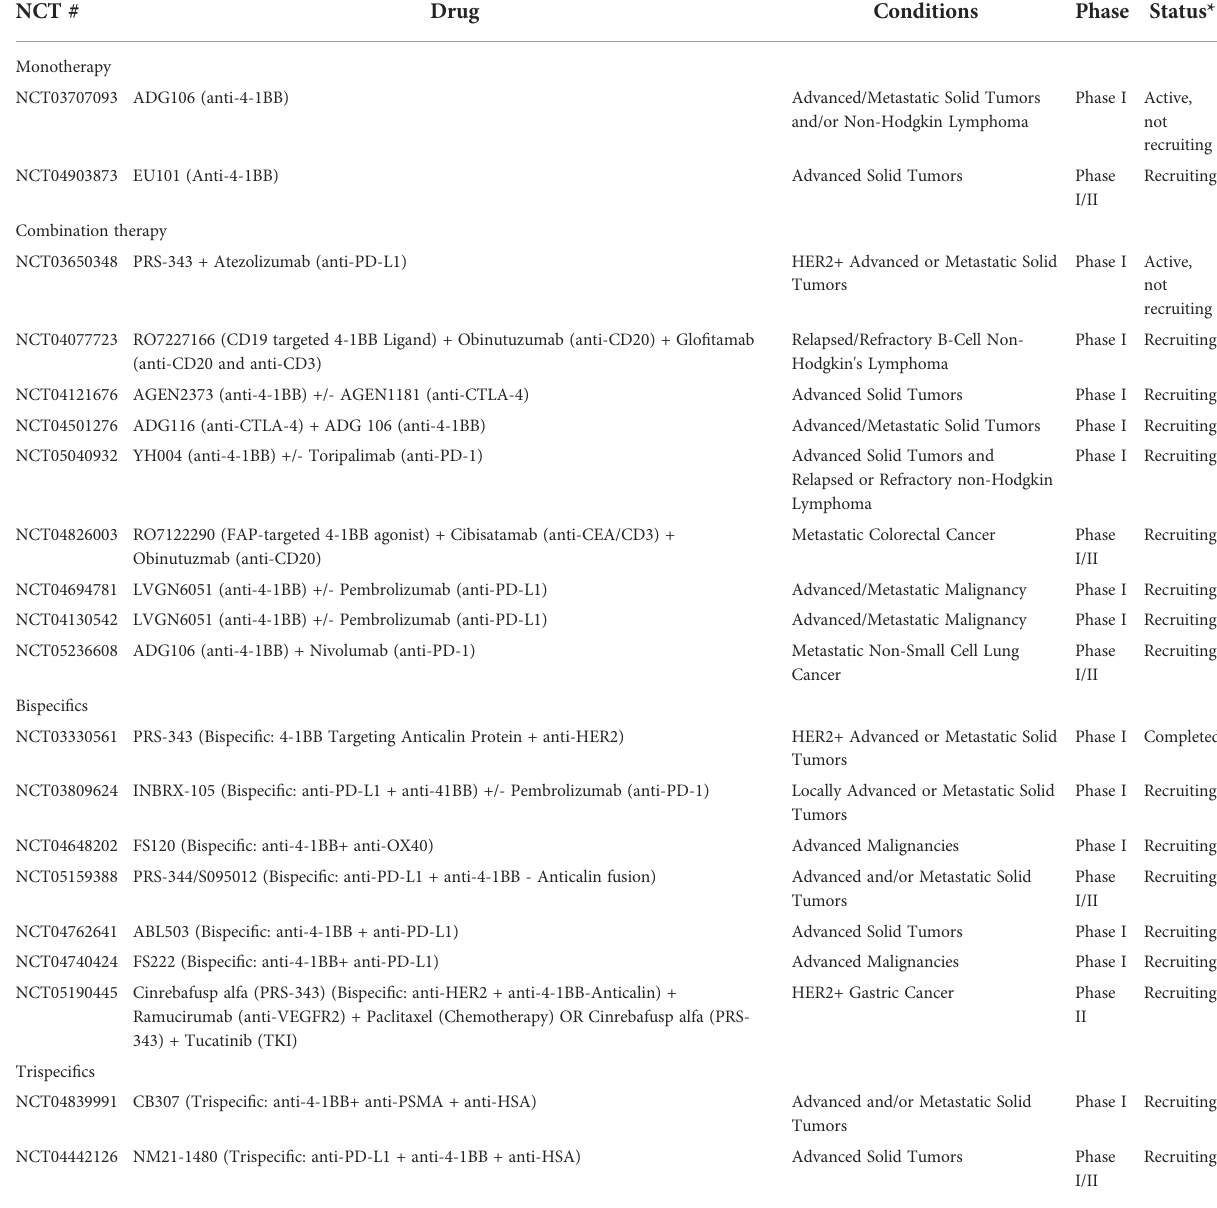
TABLE 2 Summary of clinical trials targeting 4-1BB that do not involve urelumab or